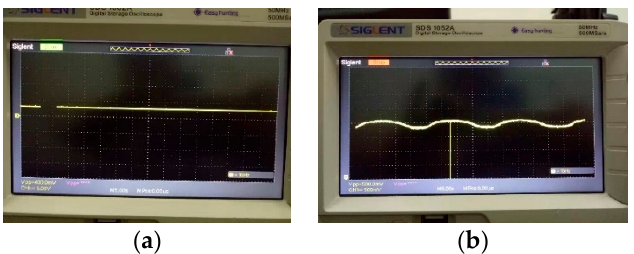
Figure 20. The output signal after the accelerometer was powered: ( a ) static signal output when the accelerometer was placed horizontally at room temperature; ( b ) sinusoidal signal output when the accelerometer rotated at low speed at room temperature (with a period of 16 s). Table 4. Results of the reference voltage test in four directions.